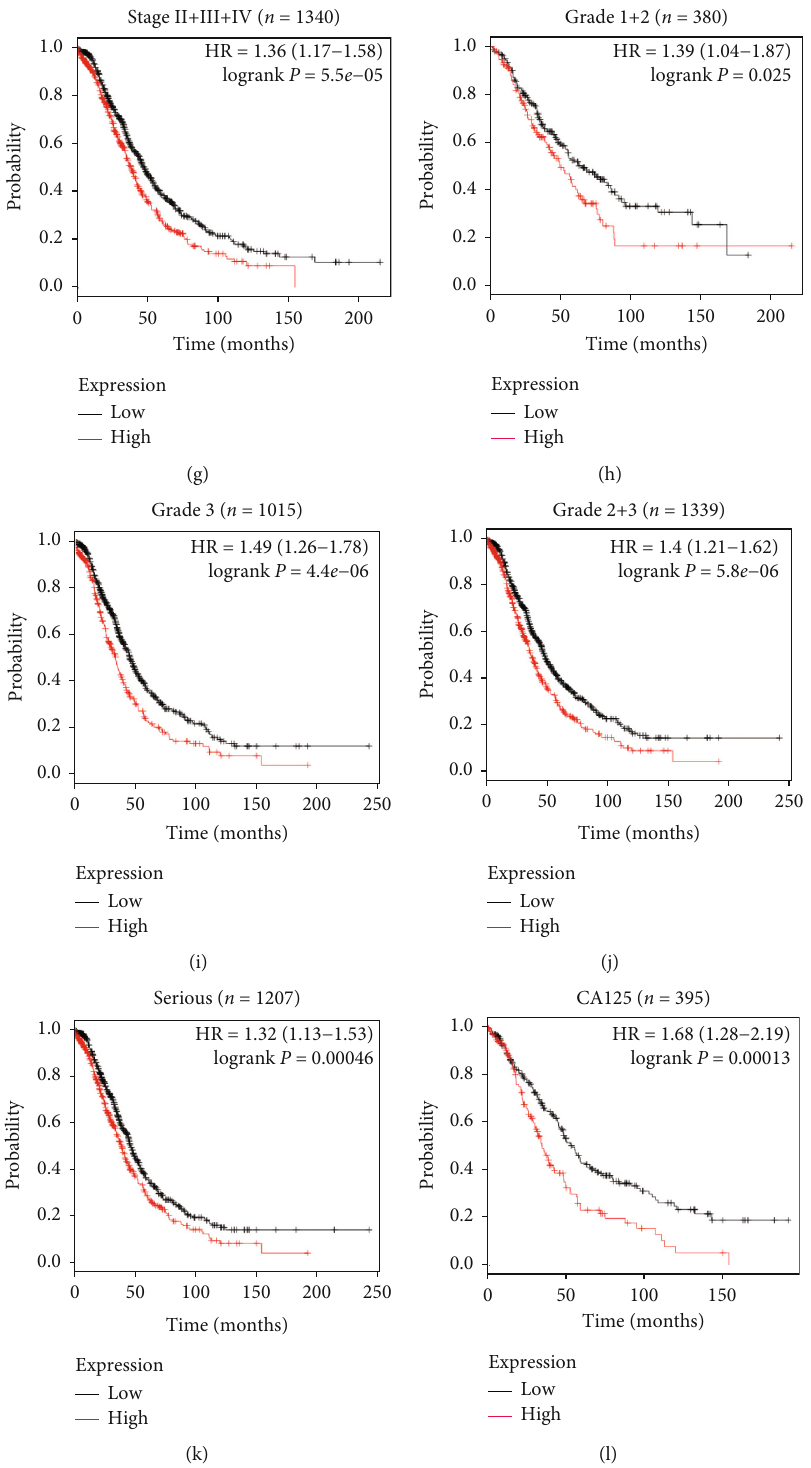
Figure 3: The Kaplan-Meier analysis of overall survival in OC patients based on K-M plotter dataset. (a) The expression of WTAP was negatively correlated with overall survival (OS) in OC patients; (b – k) Correlation between WTAP expression and overall survival was independent of clinical stage (b – g), grade (h – j), and tumor type (k). (l) High expression of WTAP predicted poor prognosis in OC patients regardless of CA125 level. P values were calculated by log-rank